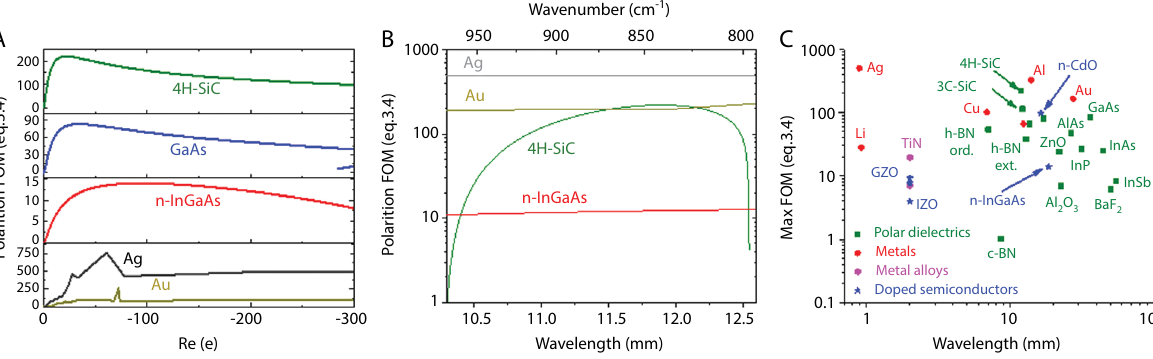
Figure 7 (A) Calculated FOM for propagating polariton modes [eq. (3.4)] for 4H-SiC (green trace) [57] and GaAs (blue trace) [59] SPhP and n-type In Ga As (red trace) [29], Ag (gray trace, using combined optical constants from Johnson and Christy [90] with Bennett and Bennett 0.3 0.7 [128]) and Au (yellow trace, using combined optical constants from Palik [89] and Ordal [109]) SPP propagating modes as a function of Re( ε ). (B) Comparison of calculated propagating polariton FOM for 4H-SiC, n-type In the Reststrahlen band of 4H-SiC (10.3–12.5 μ m). (C) Comparison of calculated propagating polariton FOM for all SPP and SPhP materials listed in Tables 1 and 2,